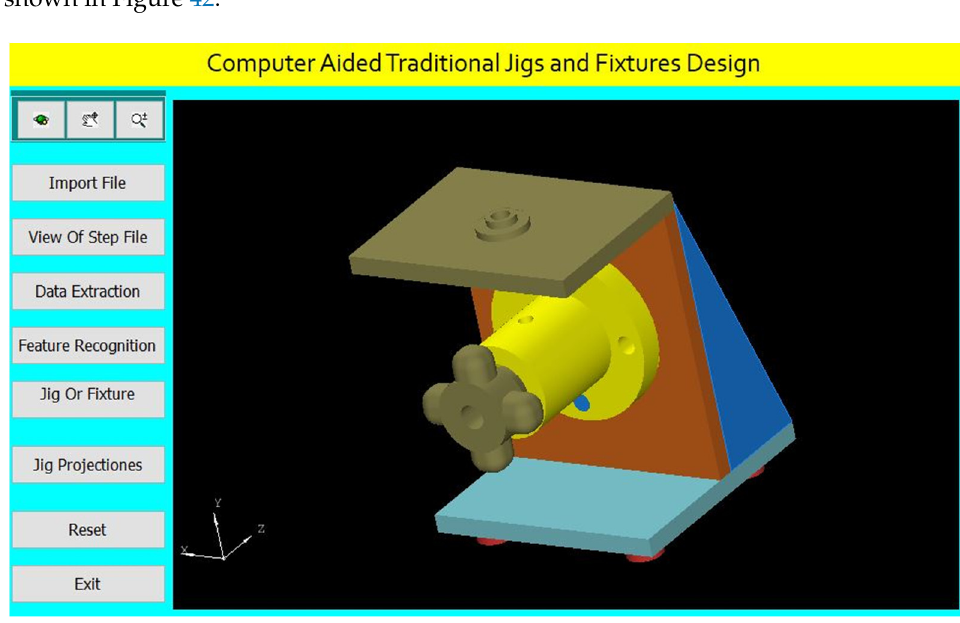
Figure 41. Automatic feature recognition of a perpendicular cross through-hole.